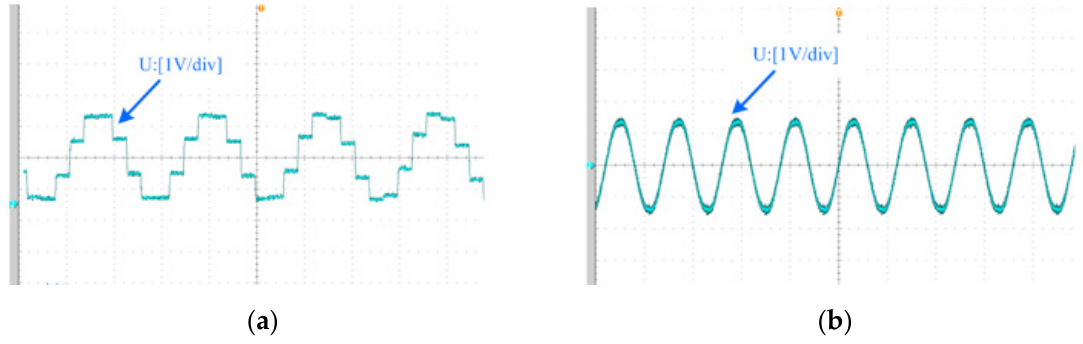
Figure 10. The power waveform of MOD system. ( a ) Unipolar stepped waves; ( b ) Bipolar sine waves.